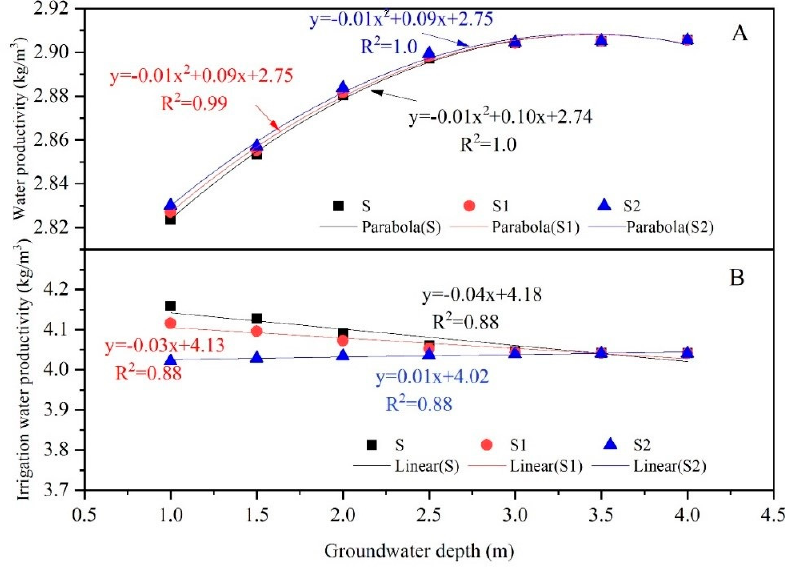
Figure 7. Relationship between water productivity, irrigation water productivity and groundwater depth, groundwater salinity. Note: ( A ) Relationship between water productivity and groundwater depth, groundwater salinity. ( B ) Relationship between irrigation water productivity and groundwater depth, groundwater salinity. Note: S, S1 and S2 refer to the scenarios with groundwater salinity of 1, 2 and 4 g / L,